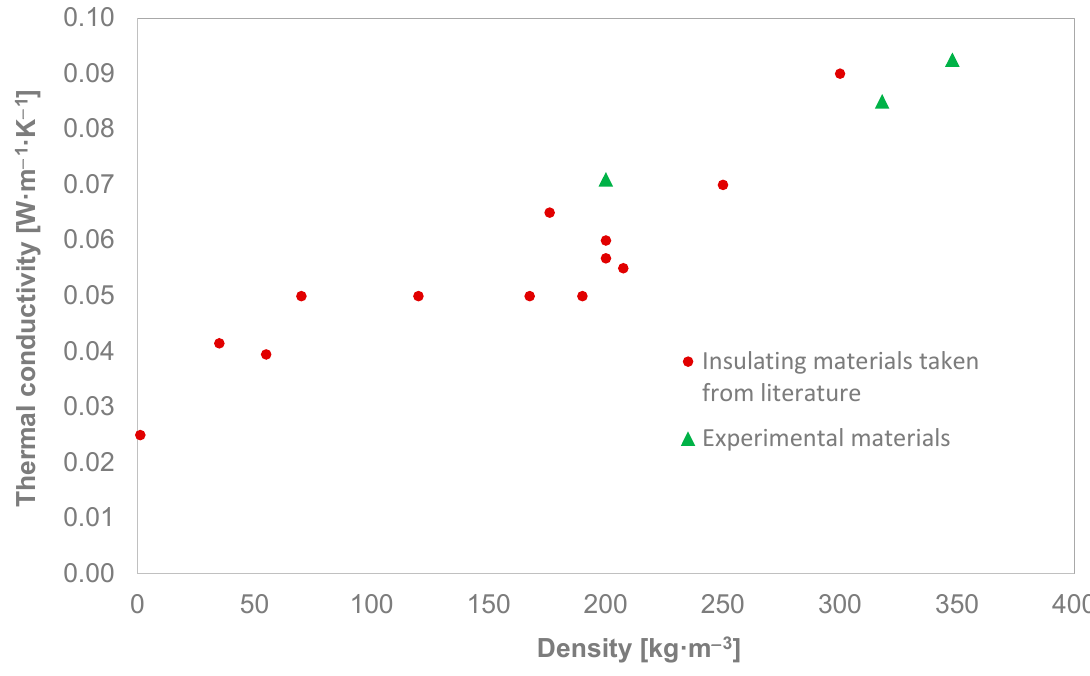
Figure 5. Comparison of thermal conductivity between tested samples and other traditional insulating materials, taken from the literature (Table 4).